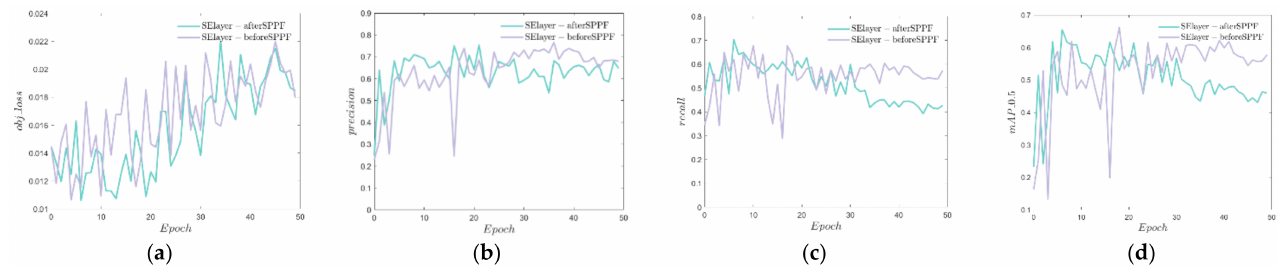
Figure 13. SE reduction parameter comparison results. ( a ) Target loss. ( b ) Accuracy rate. ( c ) Recalling rate. ( d ) mAP value.